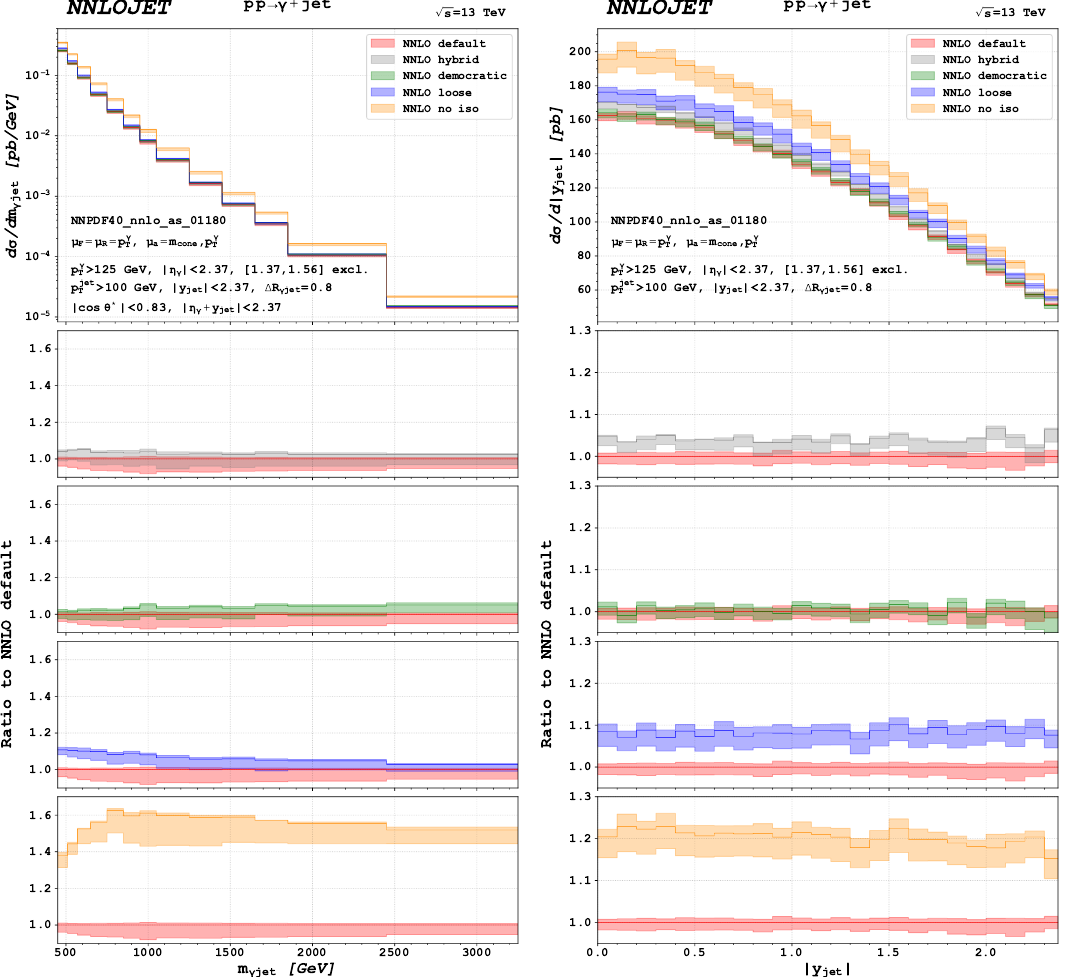
Figure 10. Predictions for the photon-jet invariant mass (left) and the leading jet rapidity distri- bution (right) using different isolation